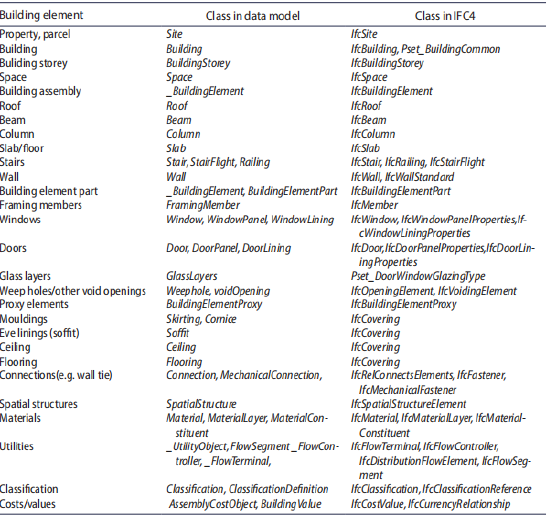
Table 4. Mapping between the proposed data model’s building relevant classes and the IFC 4 classes.